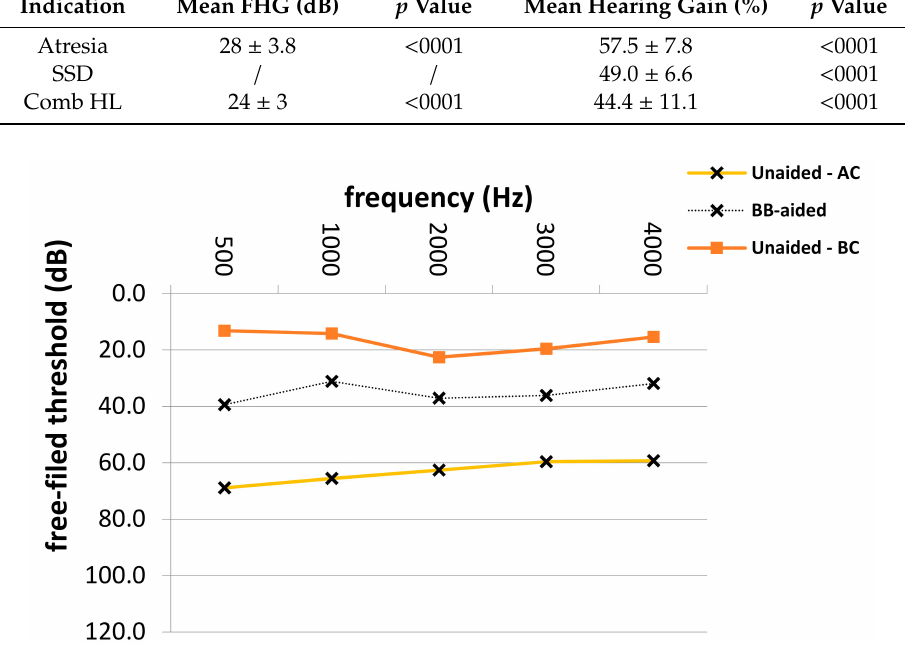
Figure 2. Aided and unaided free-field thresholds in patients with atresia. Hz: Hertz; dB: Decibel; Bb-aided; Bonebridge aided free-field audiometry thresholds, Unaided–AC; unaided air conduction audiometry thresholds, Unaided–BC; unaided bone-conduction audiometry thresholds.